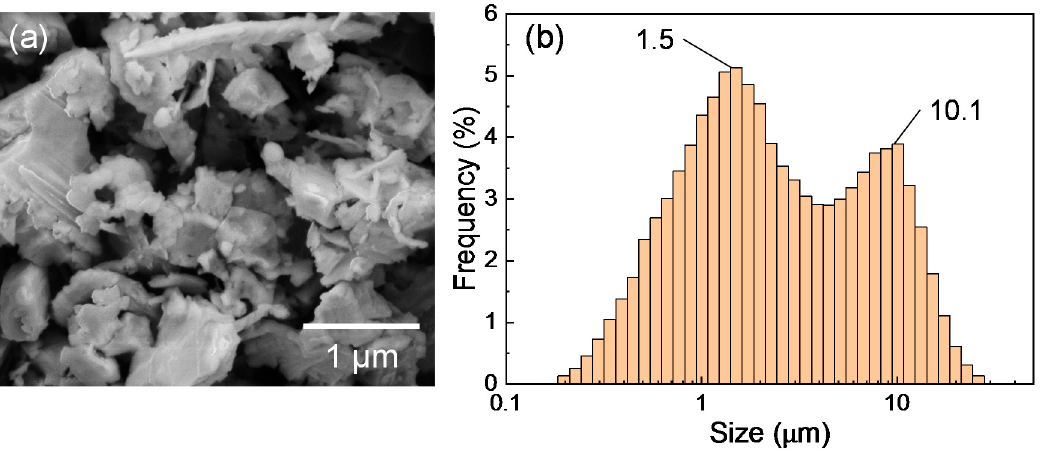
Figure 1. ( a ) SEM image and ( b ) size distribution of silicon sludge.